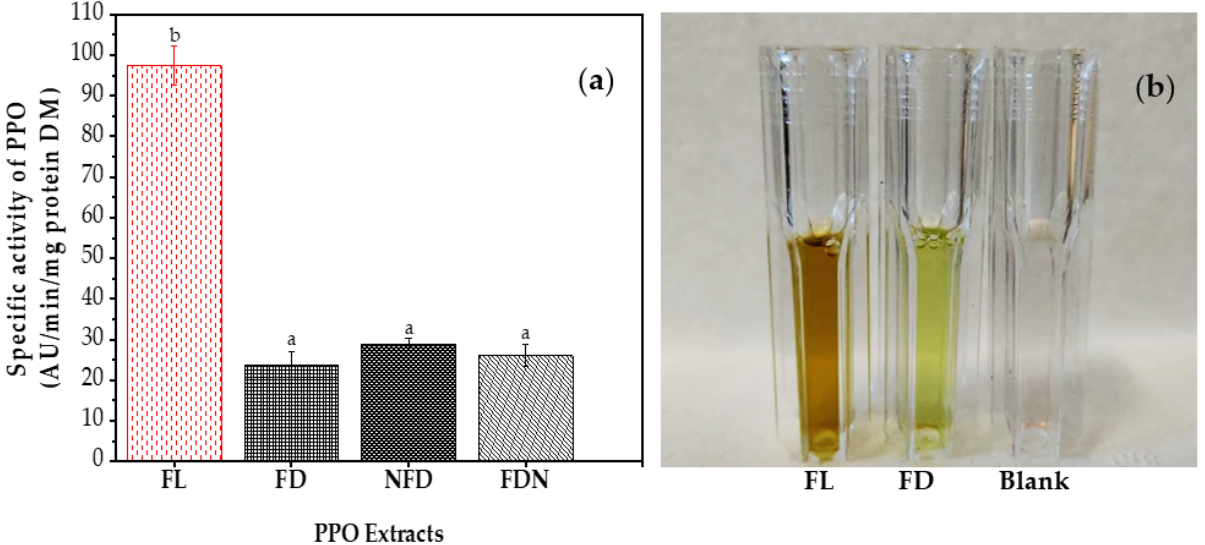
Figure 3. ( a ) Specific activity of polyphenol oxidase (PPO) in different SBLs. ( b ) Color change